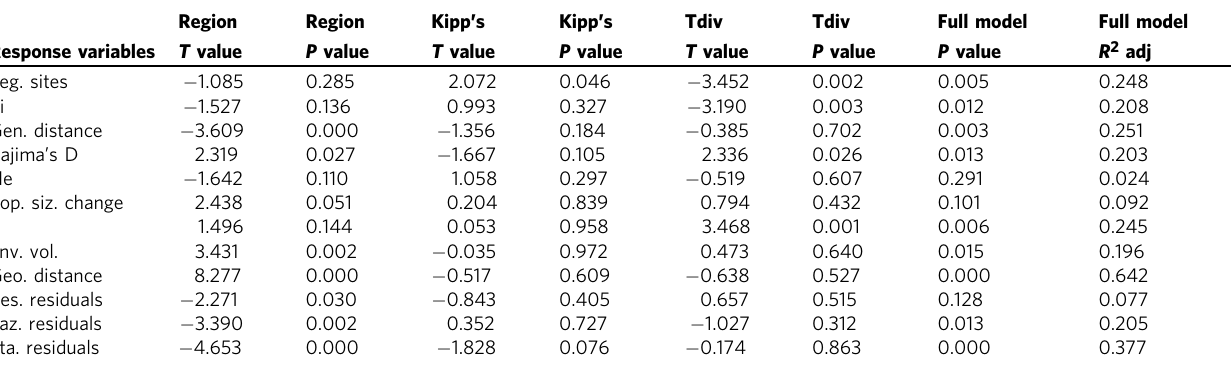
Table 2 Multivariate phylogenetic generalized least squares analyses including the effects of the region (tropical vs subtropical), Kipp ’ s index, and divergence times between populations in distinct mountain regions